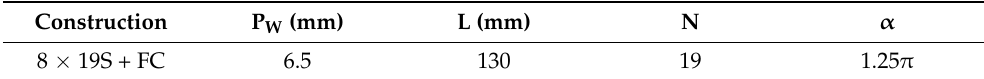
Table 1. Parameters of wire